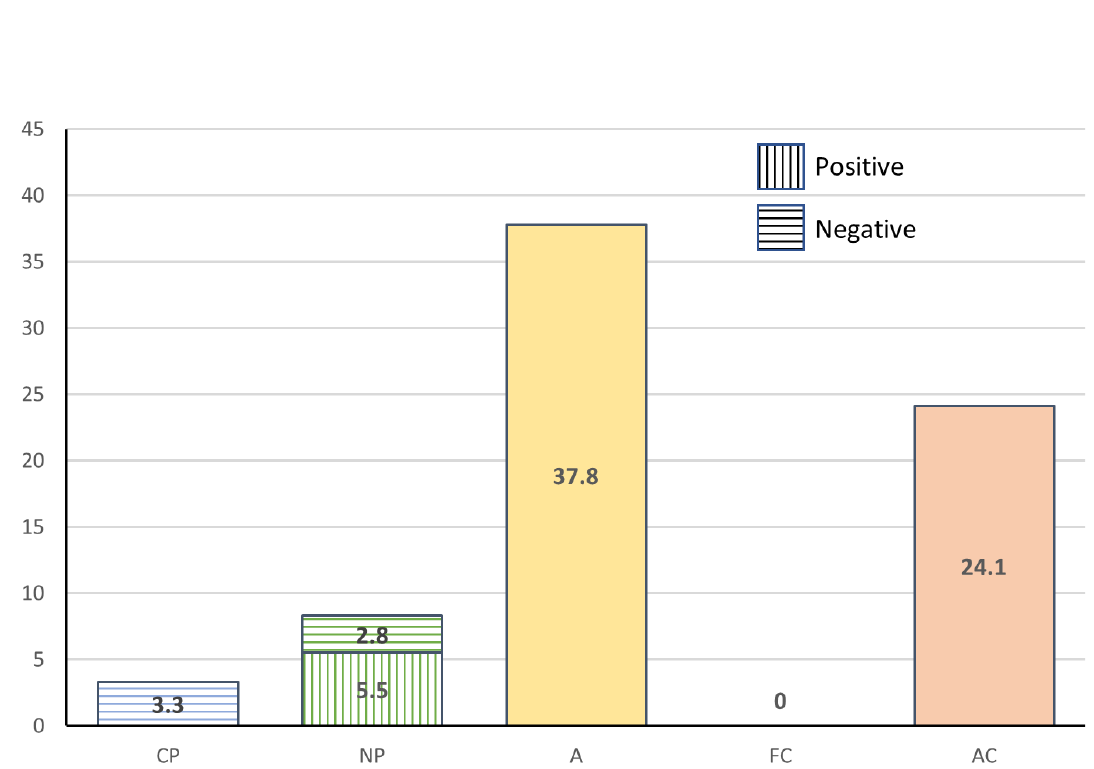
Figure 6: Sober Suicide